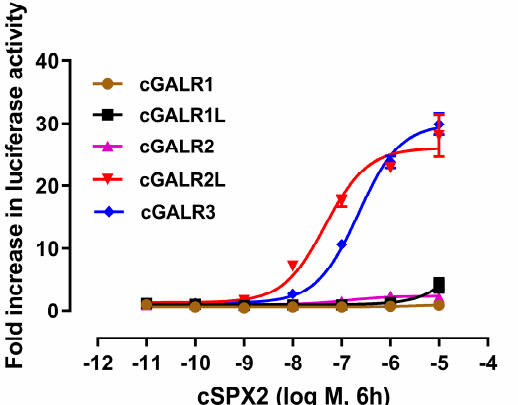
Figure 7. The effects of cSPX2 (10 − 11 –10 − 5 M, 6 h) on activating chicken galanin receptors expressed in HEK293T cells, monitored by pGL4-SRE-luciferase reporter system. Each data point represents mean ± SEM of three replicates ( n =